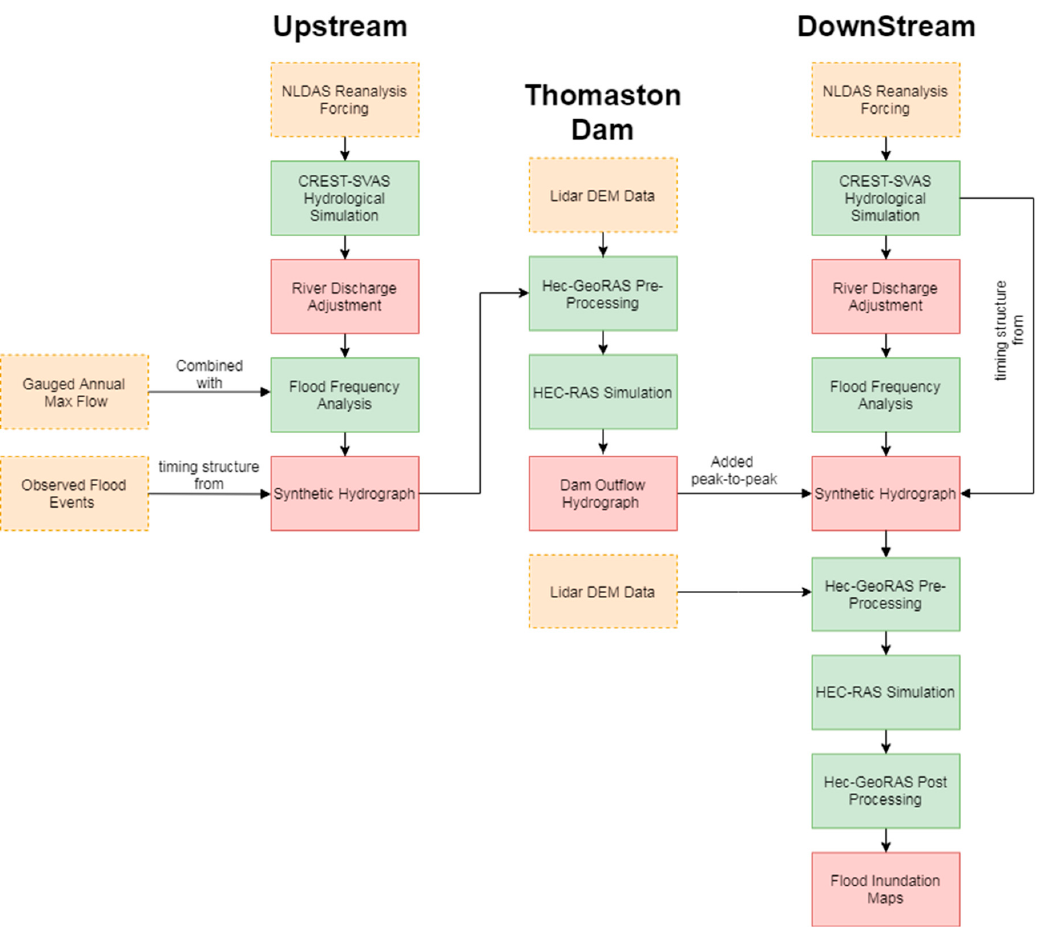
Figure 2. Structure of analysis framework.